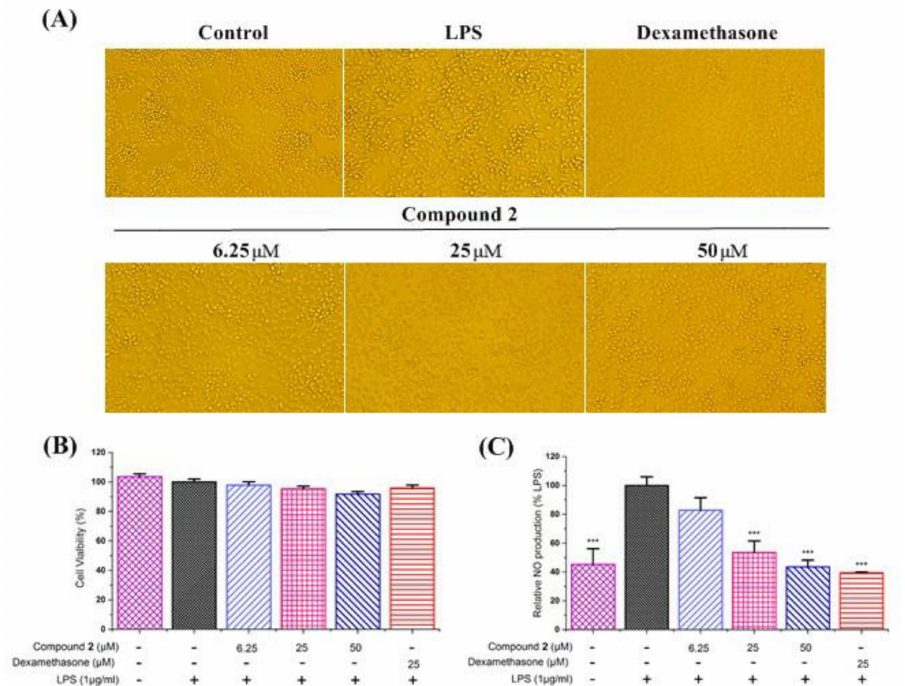
Figure 5. Effects of compound 2 on morphology ( A ), cell viability ( B ), and nitric oxide (NO) produc- tion ( C ) of LPS–stimulated RAW264.7 cells in vitro. After 24 h incubation, LPS–stimulated RAW264.7 cells were co-treated with LPS (1 µ g/mL) and various concentrations of compound 2 for another 24 h. Dexamethasone was used as a positive control. In the cell morphology assay, the cells were observed and photographed using a microscope. Cell viability was determined using the CCK–8 method by measuring the absorbance with a microplate photometer at 450 nm. In ( B , C ), the abscissa groups from left to right are the control group (without LPS), model group, compound 1 at a concentration of 6.25 µ M group, compound 1 at a concentration of 25 µ M group, compound 1 at a concentration of 50 µ M group and positive control group, respectively. In the NO production assay, the supernatants were collected for the measurement of NO production using the Griess reagent. Data are presented as mean ± SD, n = 3. One way ANOVA, *** p < 0.001, compared with LPS